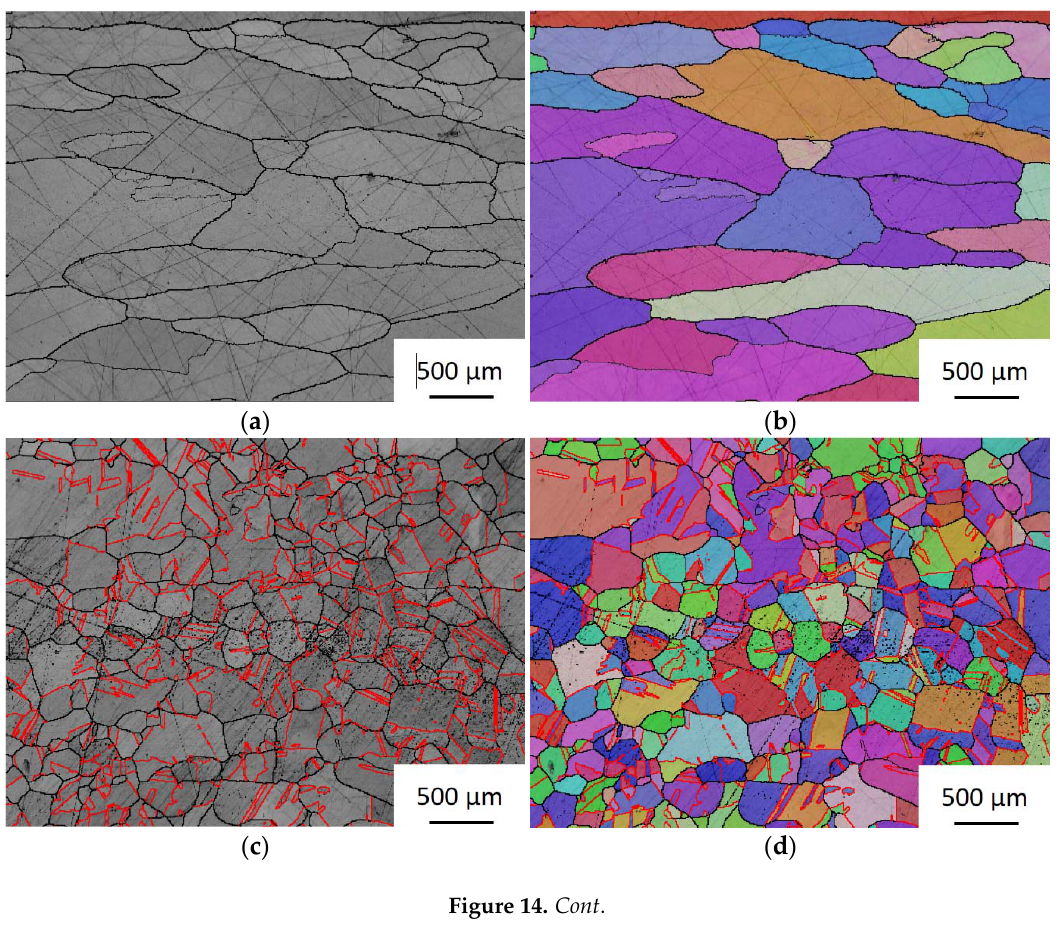
Figure 13. Electron backscatter diffraction (EBSD) analysis pole figures: ( a ) cast state; ( b ) 5% deformation; ( c ) 25% deformation.